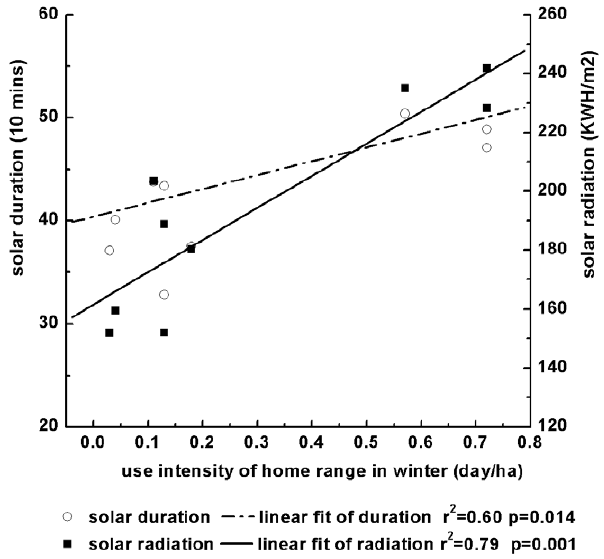
Figure 3. Relationship between range use intensity (days/ha) and sunshine duration and radiation within the winter range (mainly 4100–4400 m).